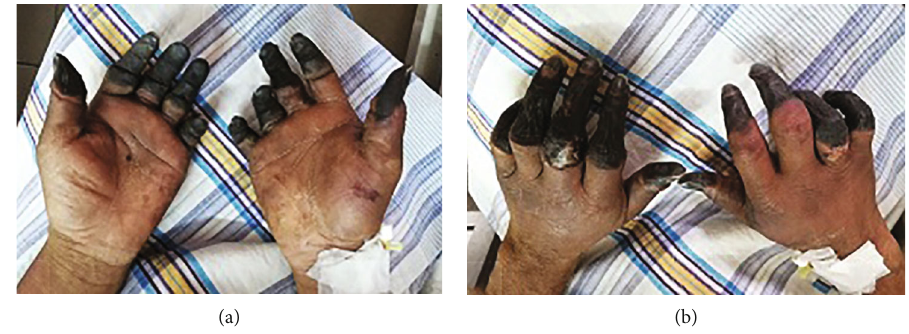
Figure 1: (a, b) Digital gangrene of the fi ngers.